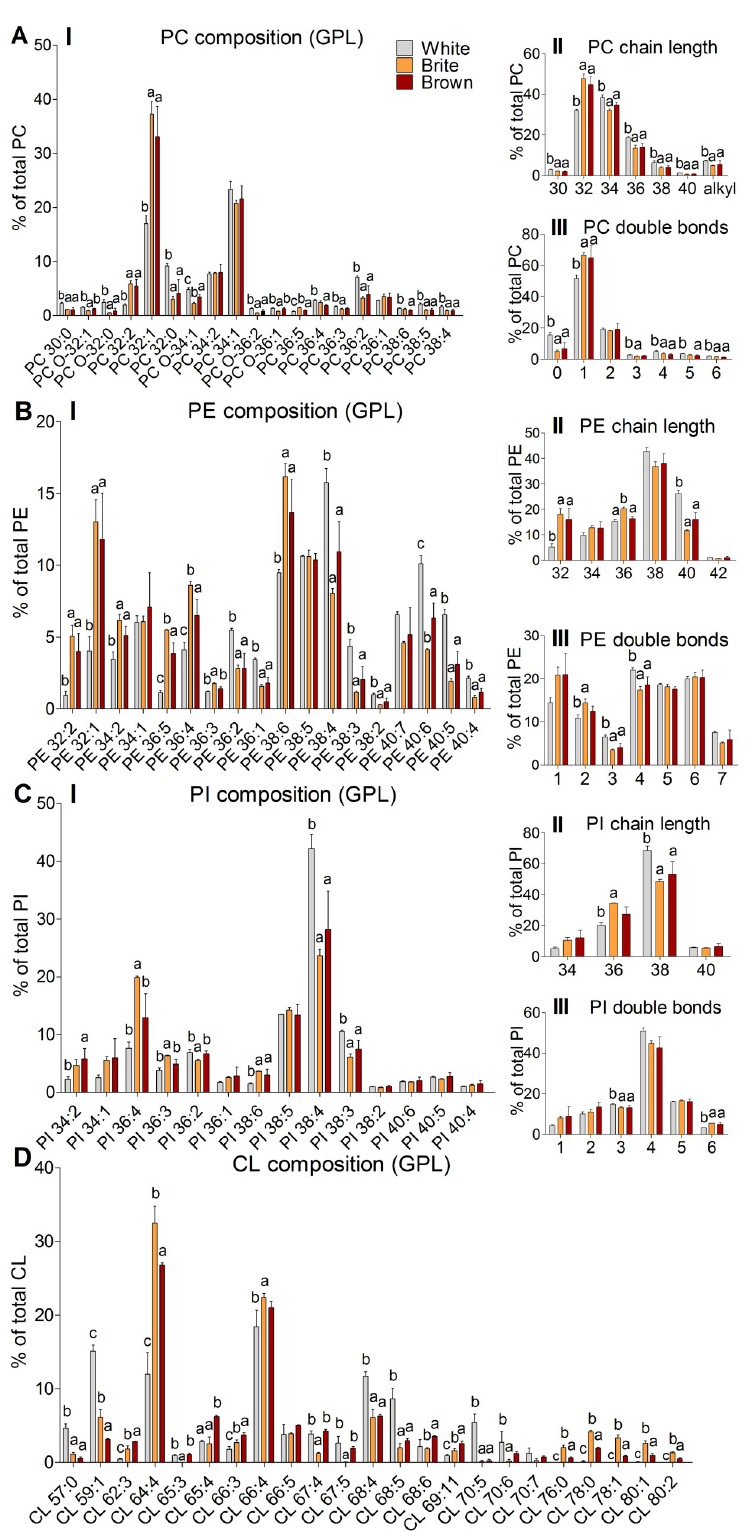
Fig 3. Lipid species profiles of major GPL from white, brite, and brown adipocytes. (A) PC, (B) PE, (C) PI, (D) CL. Panels are (I) species composition, (II) chain length as the number of carbons in the sum of FA moieties, and